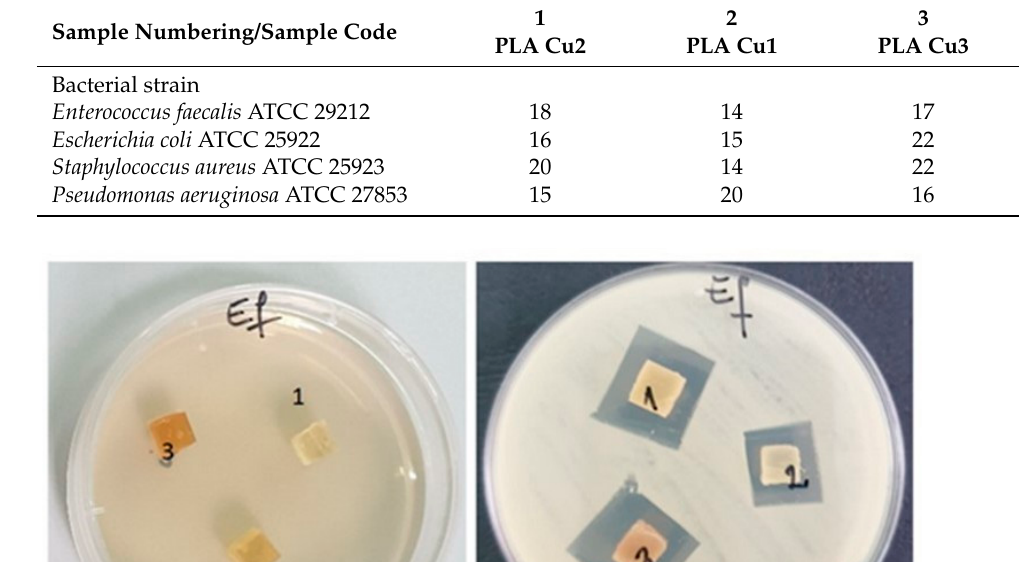
Table 8. The diameter of the bacterial inhibition zones (mm) of the tested samples.